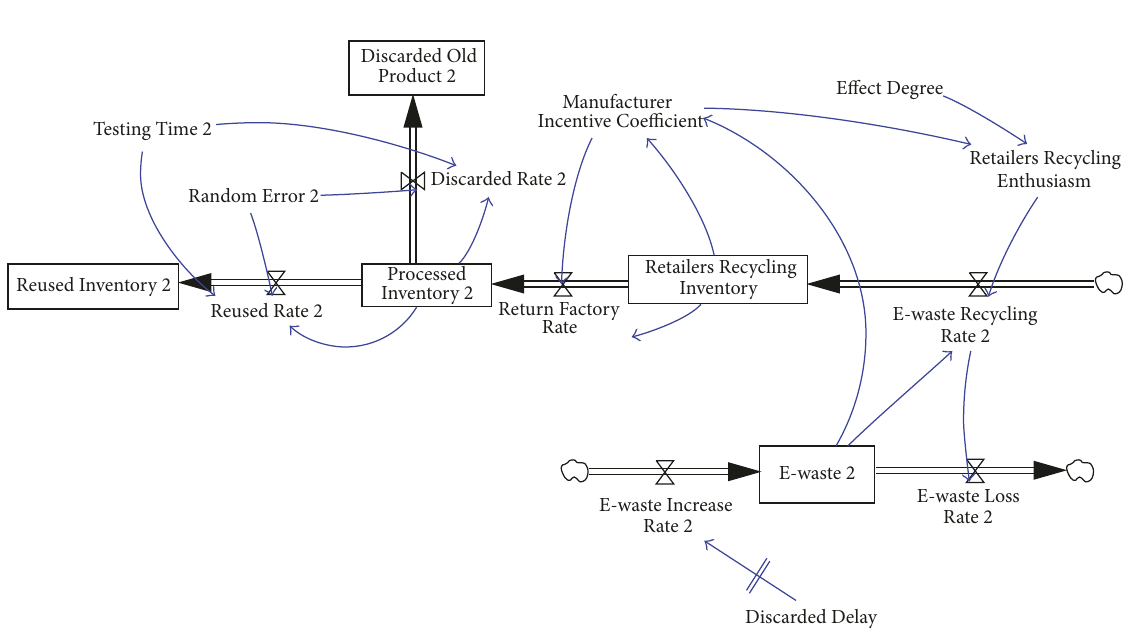
Figure 5: Contract structure flow